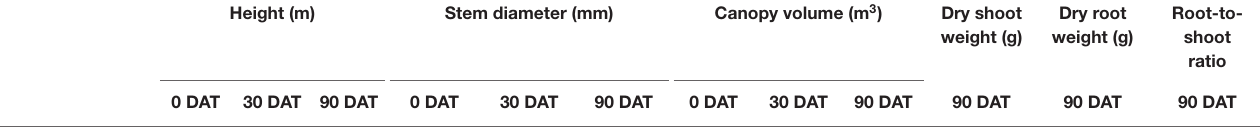
Dry root Root-to- weight (g) weight (g)